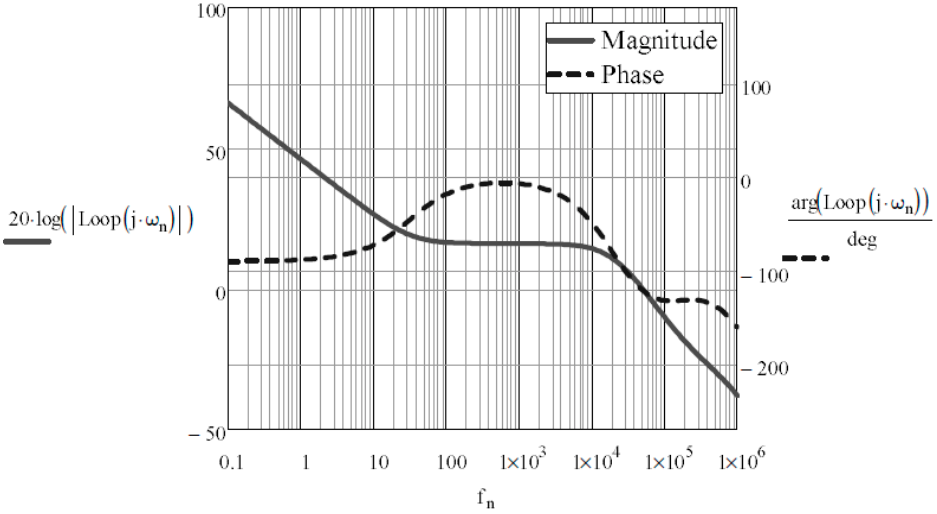
Figure 8. Frequency response of PID compensated open-loop transfer function.